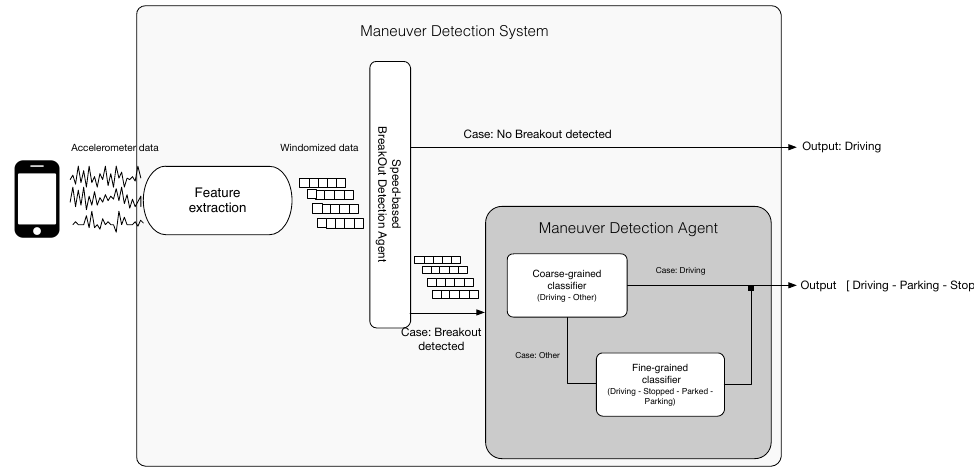
Figure 2. Architecture of the